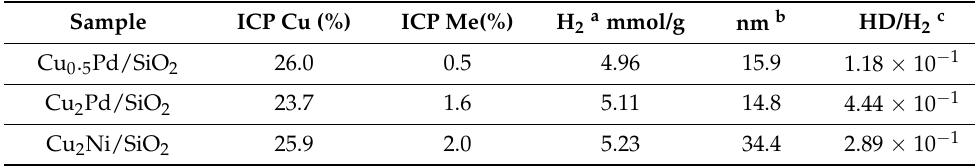
Table 2. Physico-chemical properties of bimetallic